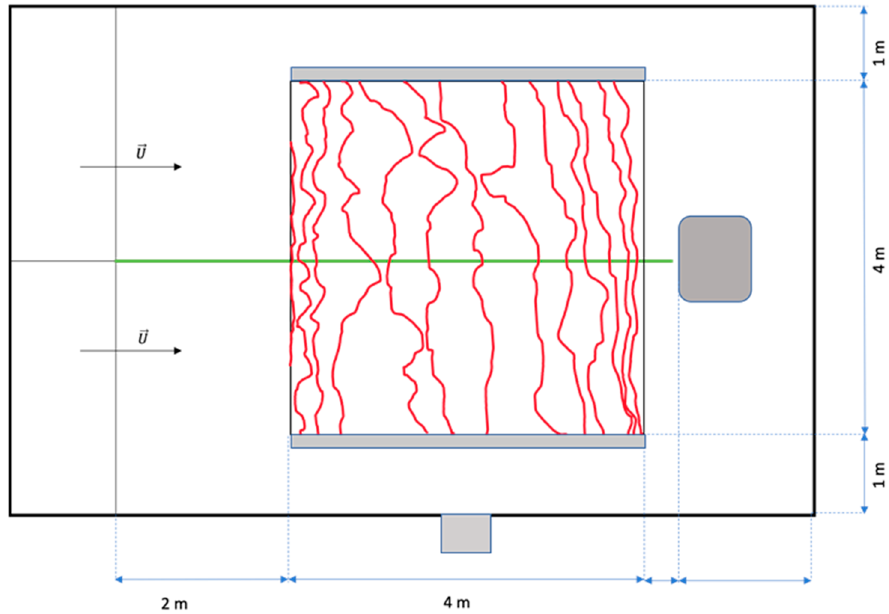
Figure 10. Fire front shape evolution for a 5 s time step—test 06 (with sidewalls). To assess the protection efficiency of the system, a non-dimensional parameter called protection effectiveness (PE) was calculated. Equation (2) gives us PE as the ratio between the difference of the external surface temperature (T3) and the inner temperature of the cabinet (T1) and the maximum possible difference in relation to the ambient temperature.